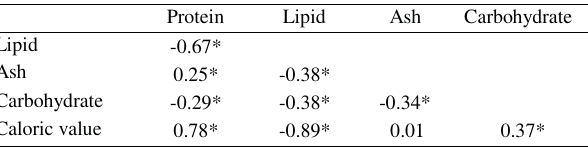
Table 4. Correlation matrix for proximate-composition (% dry mass) and caloric value (kcal g -1 dry mass) of all prey species of Trichiurus lepturus in northern Rio de Janeiro State,